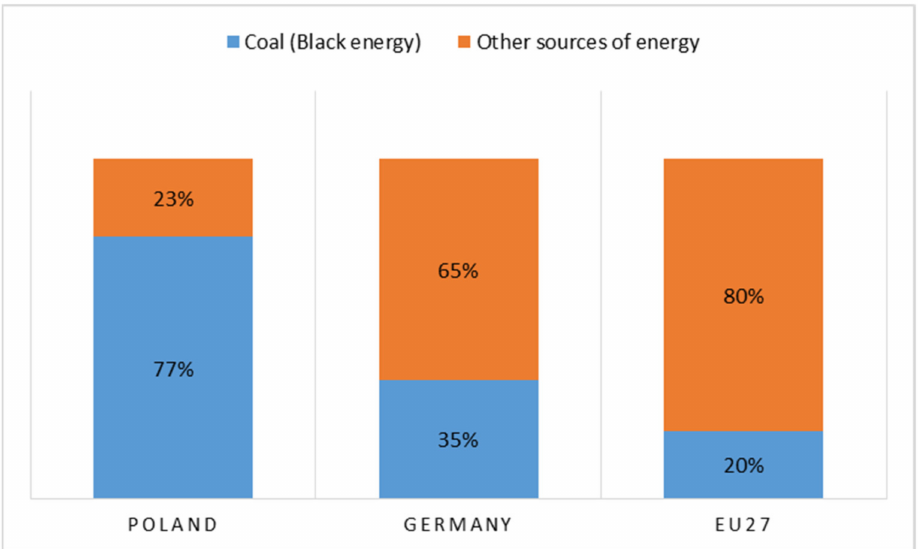
Figure 11. Comparison of the share of black energy in total for Poland, Germany, and EU 27 in 2018. Source: own elaboration based on